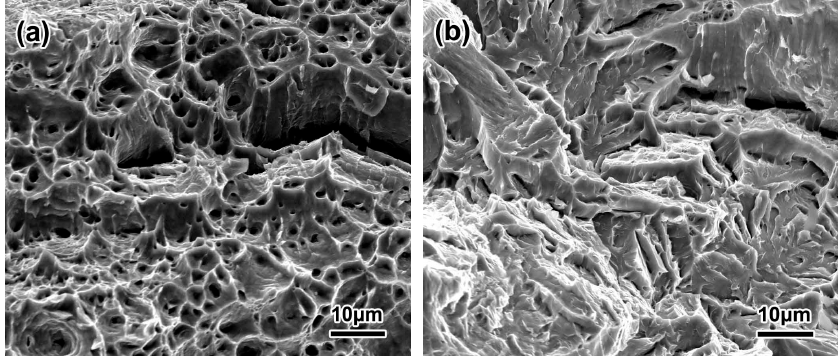
Figure 8. The fracture surface morphology of ( a ) GTA-welded HZ and ( b ) laser-welded HZ (2 kW, 1.2 m / min).